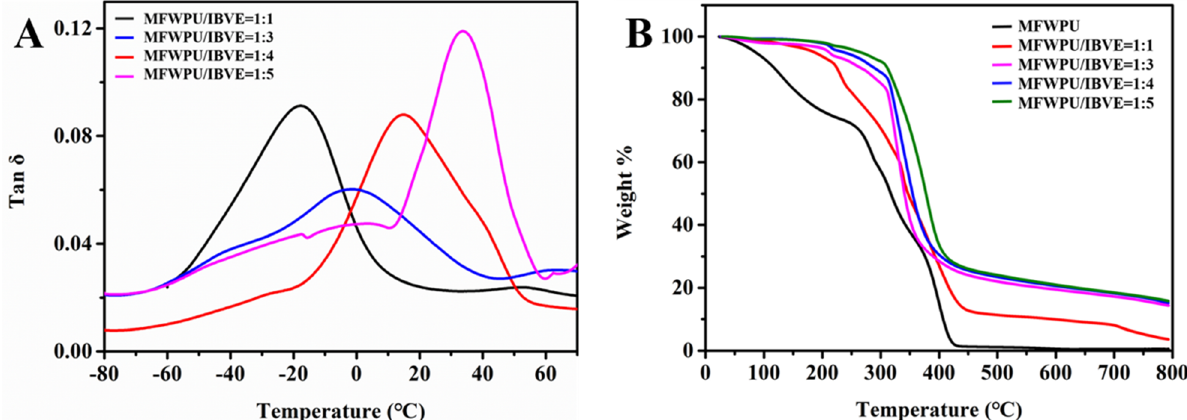
Figure 9. ( A ) TGA curves of MFWPU and P(CTFE- alt -IBVE)/MFWPU prepared with different mass feed ratios of MFWPU and IBVE; ( B ) DMA spectra of P(CTFE- alt -IBVE)/MFWPU composite coatings prepared with different mass feed ratios of MFWPU versus IBVE.